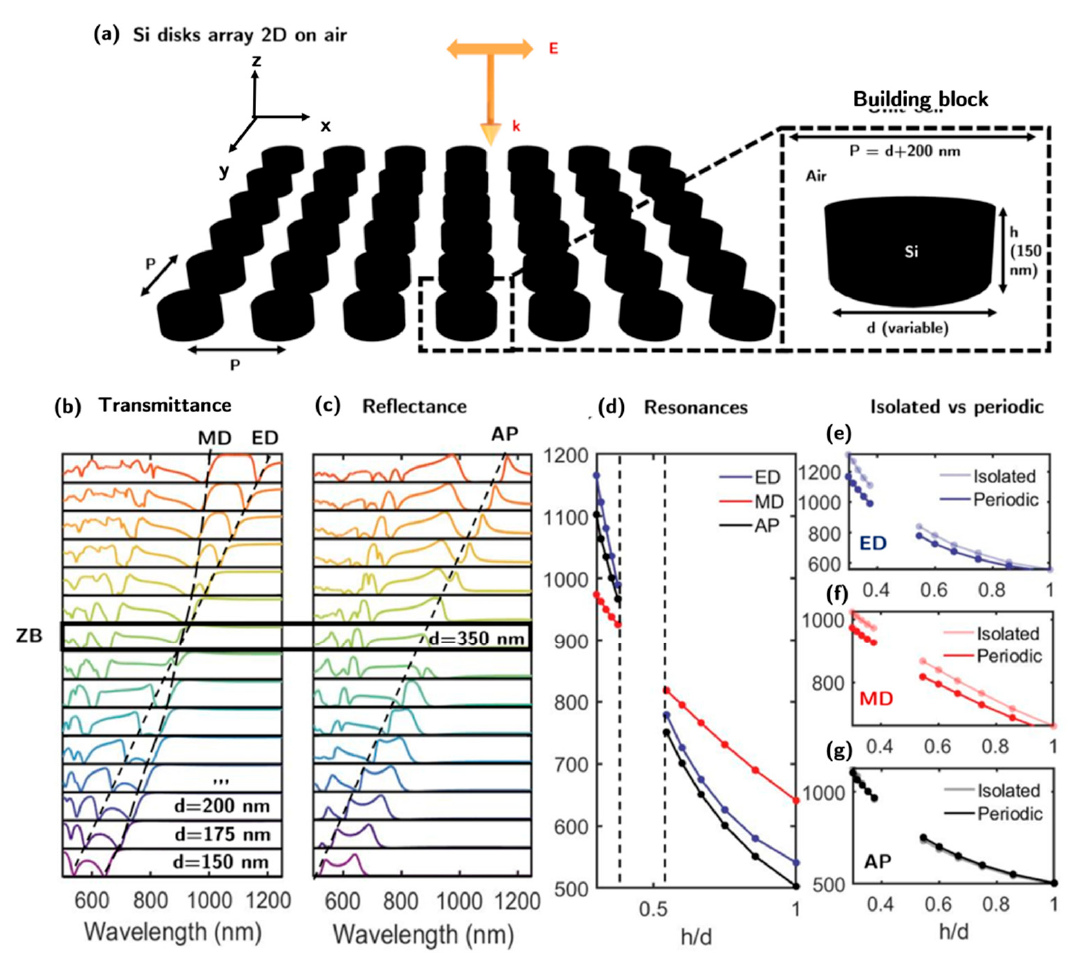
Figure 3. ( a ) A two-dimensional array made of silicon nanodisks in air illuminated normally by a plane wave. ( b , c ) Transmittance and reflectance, respectively, of a silicon disk metasurface as a function of the disk diameter, d, ranging from 150 to 500 nm. Dashed lines indicate the spectral positions of ED and MD (in the transmittance spectrum) and AP resonances (in the reflectance spectrum), respectively. ( d ) The spectral position of MD, ED, and AP resonances as a function of the aspect ratio h/d . There is no data available between h/d = 0.37 and 0.50 as it is difficult to accurately determine the spectral position of the resonances due to their spectral overlap. ( e , f , g ) Spectral positions of ED, MD, and AP resonances, respectively, as a function of h/d . Each case is compared with the isolated disk.